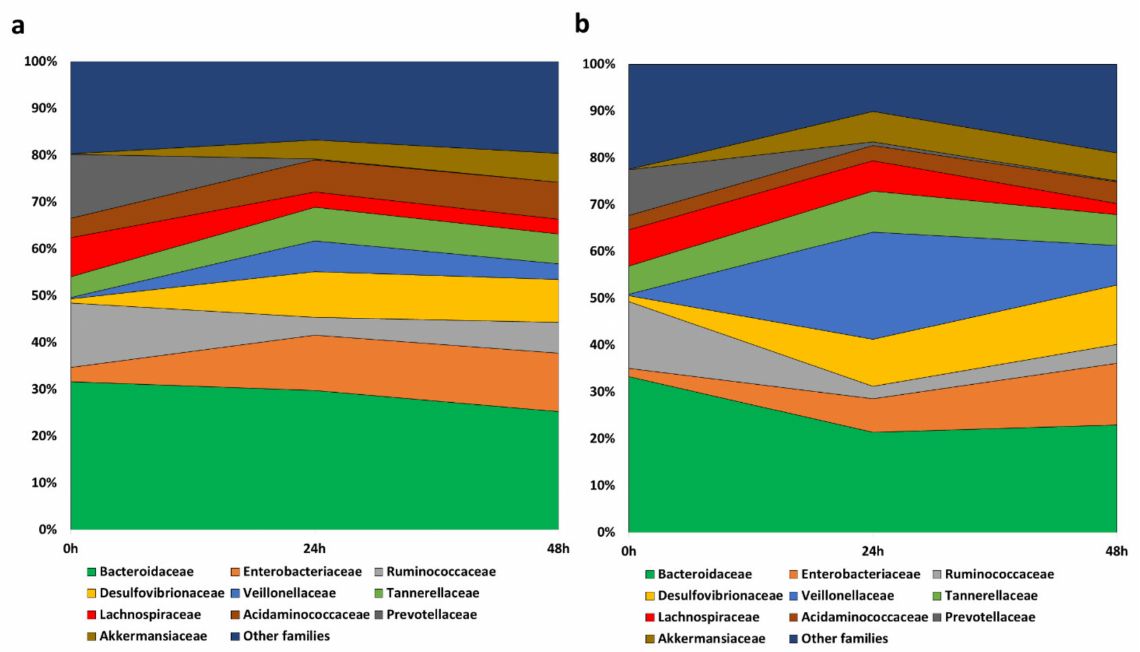
Figure 4. The evolution of bacterial families with relative abundance higher than 5% during faecal fermentations in the absence ( a ) and presence ( b ) of the intestinal-digested extract